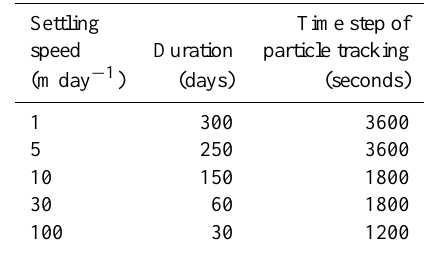
Table 2. Inputs of the ICHTHYOP model parameters used to pro- cess the Lagrangian simulation of particles